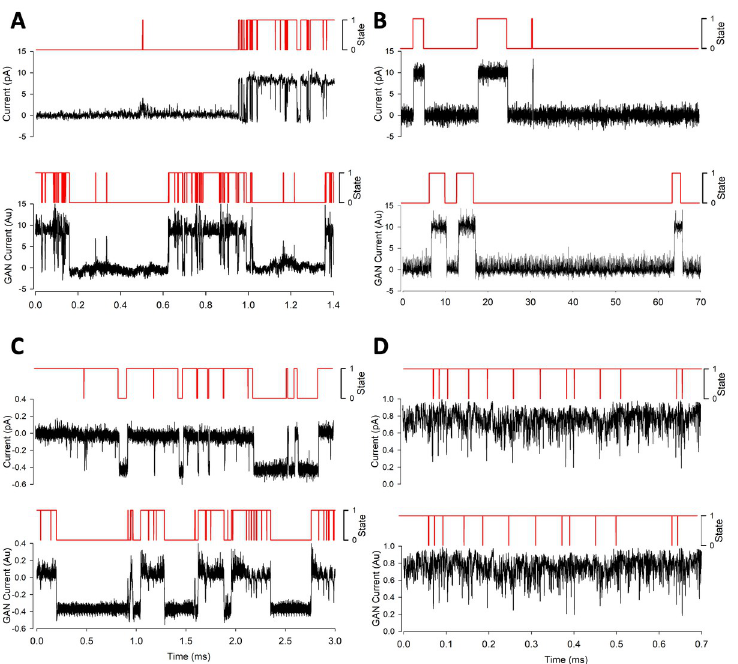
Fig 5. Sample data from both real dataset and DeepGANnel model output from numerous ion channels. In each subpanel, real raw and labelled data is displayed on top with simulated data below. (A): “Channel phenotype A” canine articular chondrocyte sample data and model output. (B): “Channel phenotype B”, WinEDR simulated sample data and model output. (C): “Channel phenotype C” tracheal chondrocyte sample data and model output. (D): “Channel phenotype D” PVN sample data and model